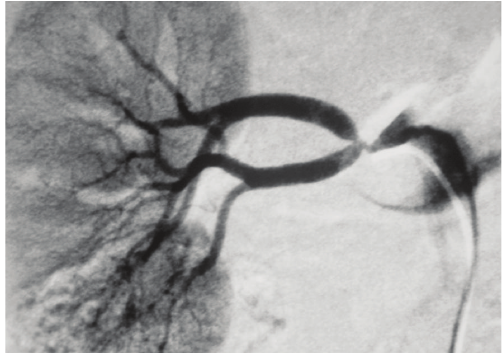
Figure 1: Bifurcation stenosis of the right renal artery. Figure 2: Postdilatation image with two monorail balloons through the same introducer (deflated balloons can be seen into the renal artery branches).